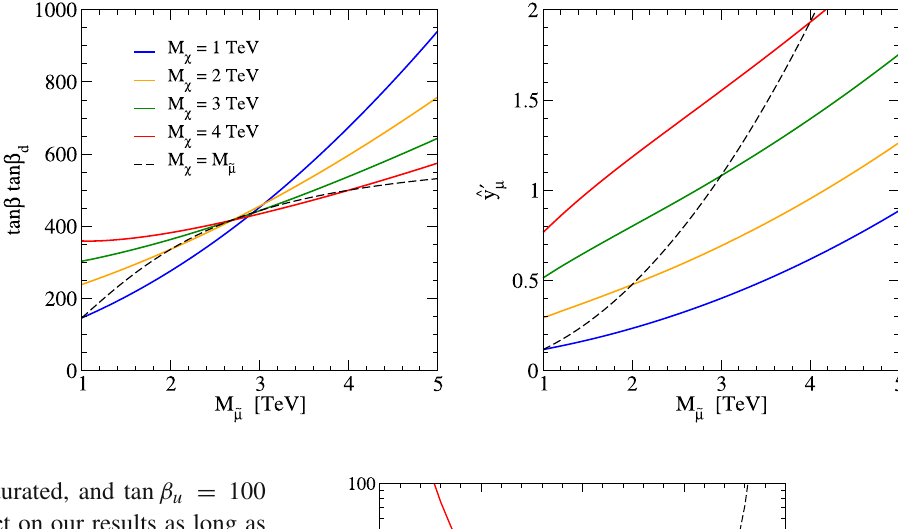
λ in Eq.(20) is essentially saturated, and tan β u = 100 SM (the latter choice has little impact on our results as long as